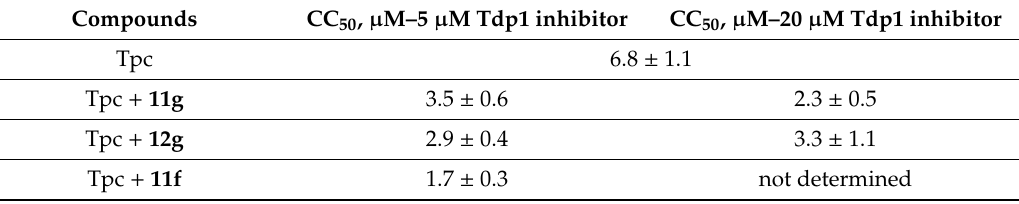
Table 3. The influence of the Tdp1 inhibitors at 5 µ M on the cytotoxic potential of topotecan (Tpc).